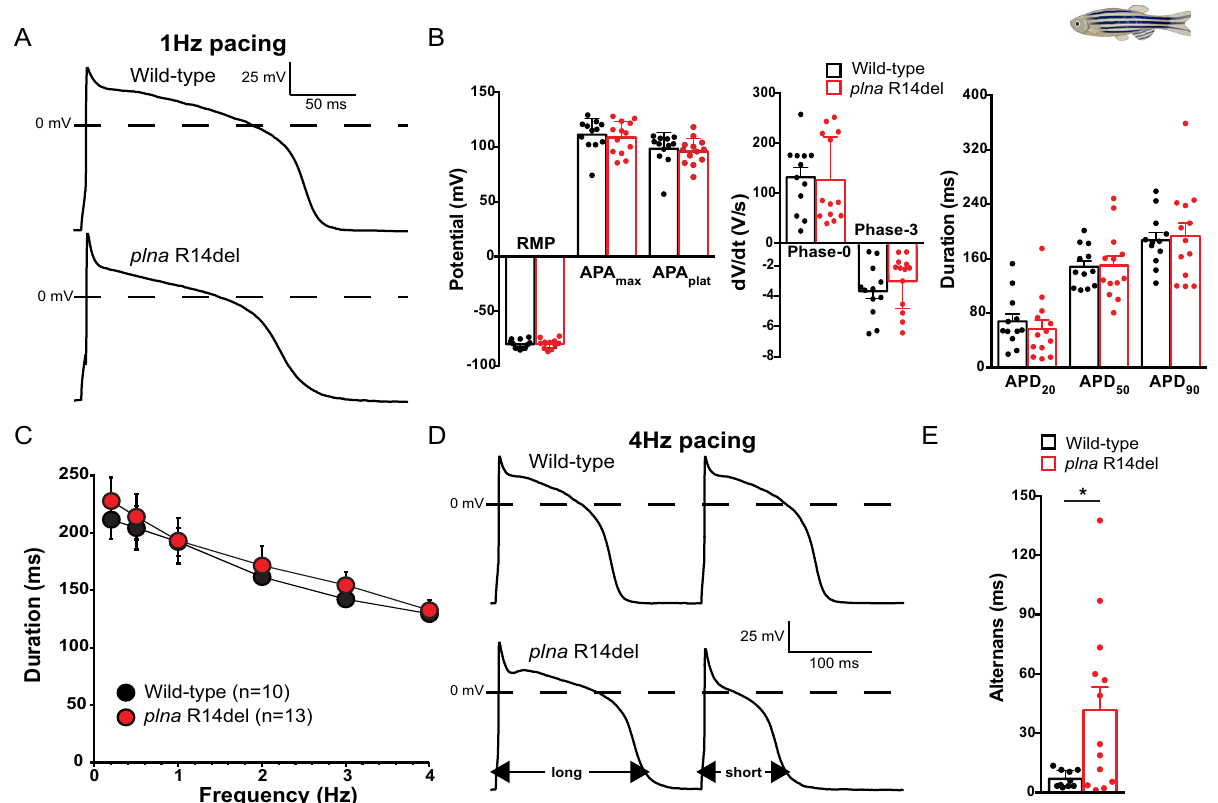
Fig. 4 Action potential alternans in plna R14del isolated cardiomyocytes. A Typical action potentials (APs) of cardiomyocytes isolated from a 10-month- old wild type (WT) (top panel) and plna R14del mutant (bottom panel) zebra fi sh, paced at 1 Hz. B Average AP parameters at 1 Hz pacing (mean ± SEM, WT n = 12, plna R14del n = 13, unpaired Students t -test). C AP duration at 90% of repolarization (APD 90 ) at 0.2 – 4 Hz pacing (mean ± SEM, WT n = 10, plna R14del n = 13, unpaired Students t -test). D Two consecutive APs during 4 Hz pacing in a WT (top panel) and plna R14del (bottom panel) cardiomyocyte. The plna R14del cardiomyocyte showed an AP alternans where a long AP is followed by a short AP. E Average APD 90 difference between two consecutive APs (alternans) during 4 Hz pacing (mean ± SEM, * p = 0.044, WT n = 10, plna R14del n = 13, Mann – Whitney rank-sum test). Wild type are highlighted in black and plna R14del in red. WT wild type, Hz Hertz, mV millivolt, ms milliseconds, V/s Volts per second, RMP resting membrane potential, APA max maximal action potential amplitude, APA plat action potential amplitude at plateau phase, APD 20 AP duration at 20% of repolarization, APD 50 AP duration at 50% of repolarization, APD 90 AP duration at 90% of repolarization. Source data are provided as a Source Data fi